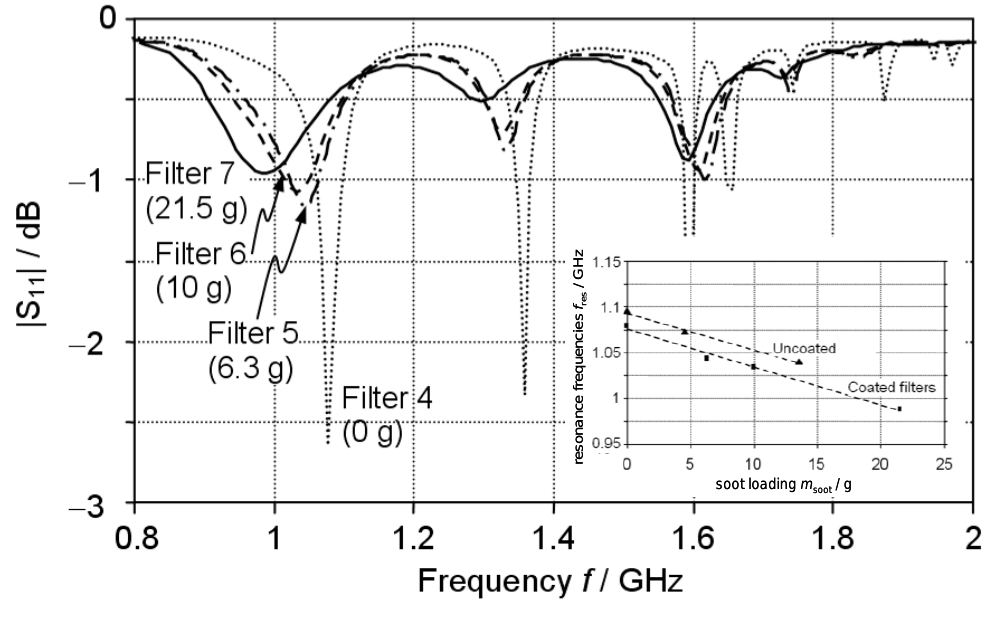
| is given in dB. Slightly modified 11